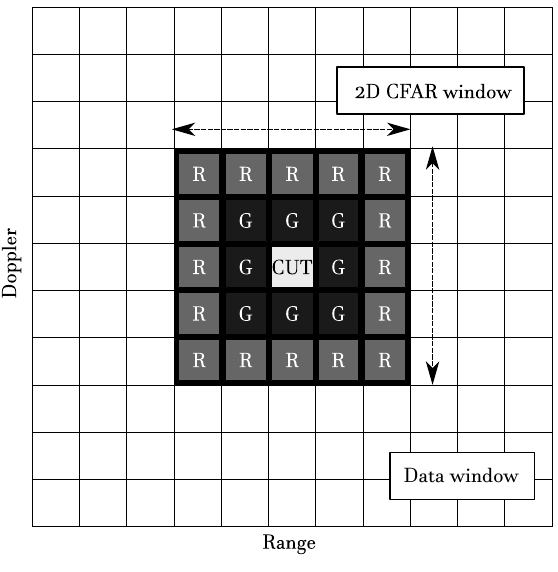
Figure 9. 2D CFAR